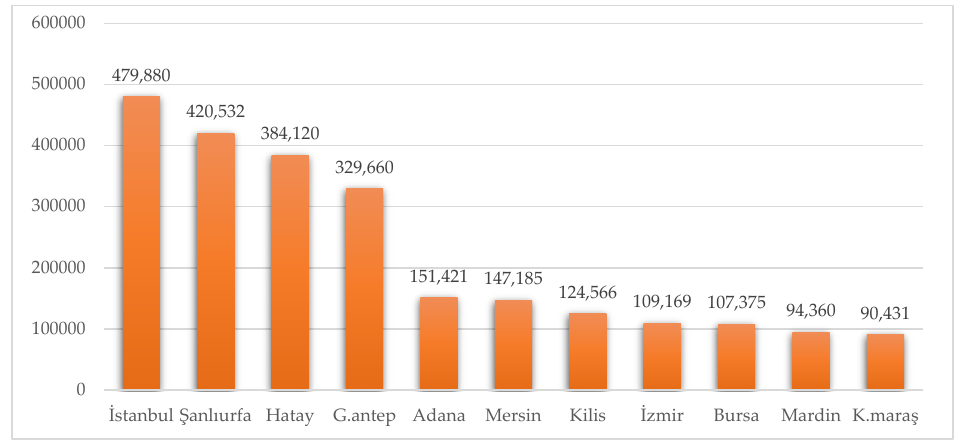
Figure 1. Top ten cities where Syrian refugees reside (2016). Source: Directorate General of Migration Management.